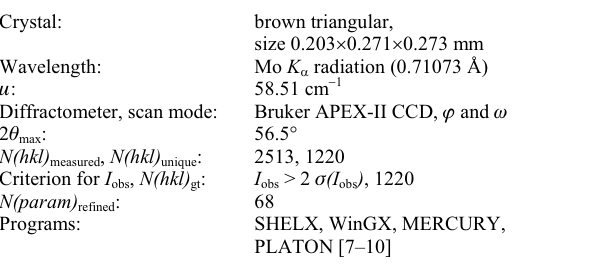
Table 1. Data collection and